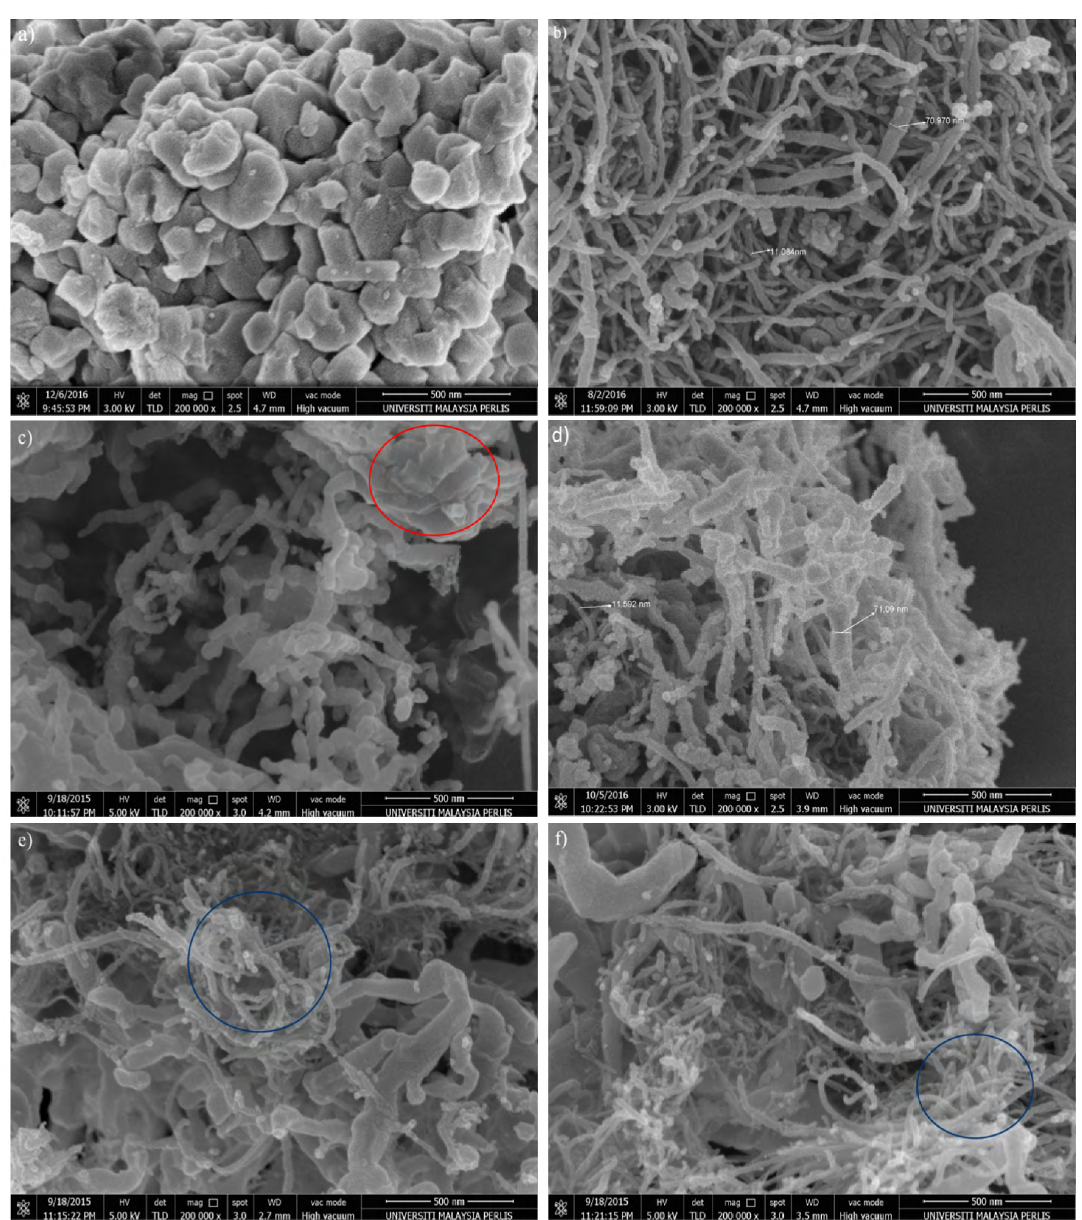
particles, b) MWCNTs and SiCNTs synthesized from blend of SiO and MWCNTs in the ratio of Figure 4. FESEM images of a) SiO 2 2 c) 1:1; d) 1:3; e) 1:5 and f) 1:7. Red circle: Silicon dioxide particle (SiO ), Blue circle: Multi-walled carbon nanotubes (MWCNTs). 2 that inter-planar spacing of SiC nanowire was observed to be 0.25 nm. It can be that diameter of SiCNTs in TEM image was in 13 nm which is in good consistence with the diameter of SiCNTs in the range of 11-71 nm as observed in FESEM